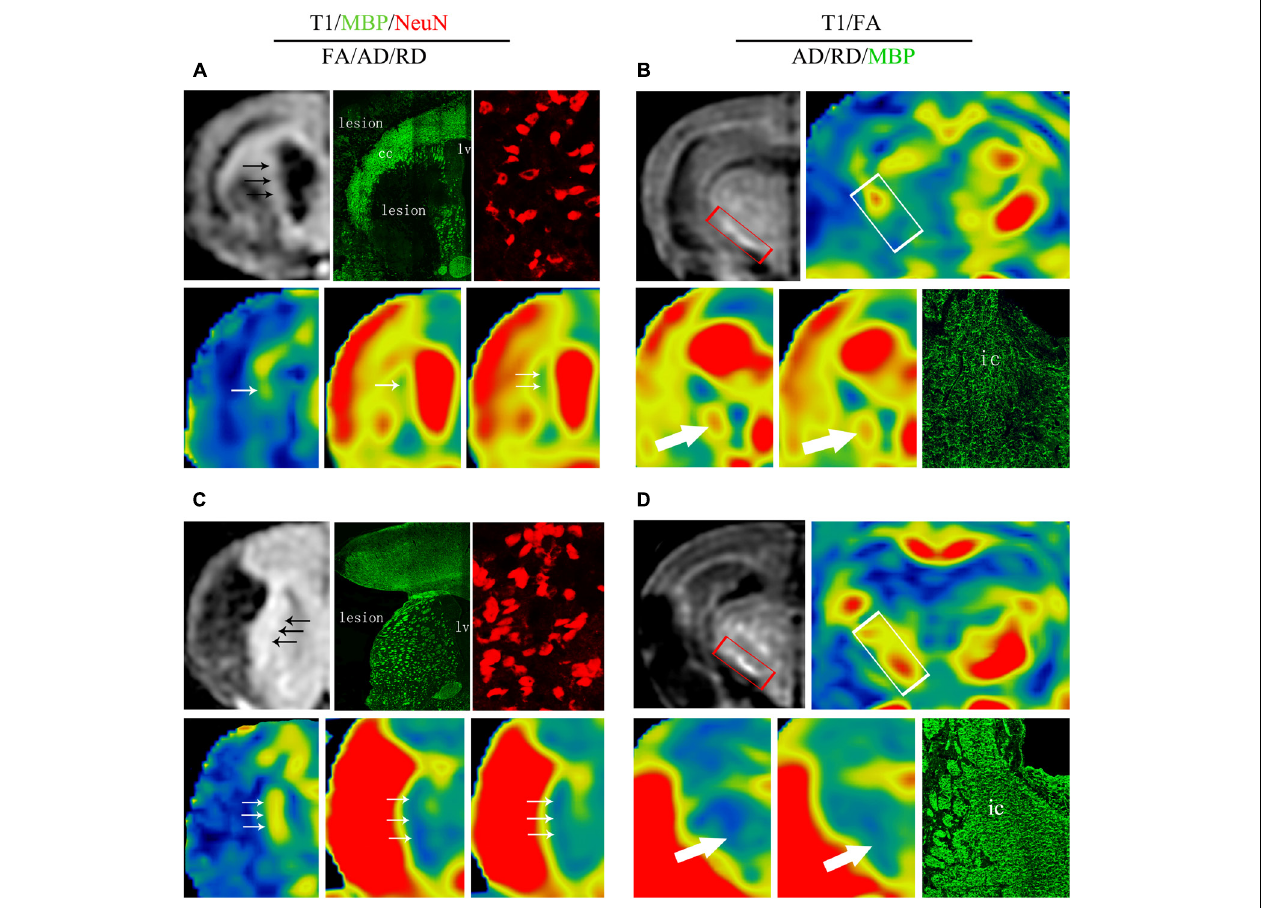
FIGURE 10 | Comprehensive analysis about effects of DAPT on structure-based and cell-based changes in ipsilateral STR and IC 8 weeks after MCAO. (A) Representative images of T1 MR, MBP, NeuN, FA, AD and RD of ischemic boundary in vehicle rats. (B) Representative images of T1 MR, FA, AD, RD, and MBP of ipsilateral IC in vehicle rats. (C) Representative images of T1 MR, MBP, NeuN, FA, AD, and RD of ischemic boundary in DAPT-treated rats. (D) Representative images of T1 MR, FA, AD, RD and MBP of ipsiateral IC in DAPT-treated